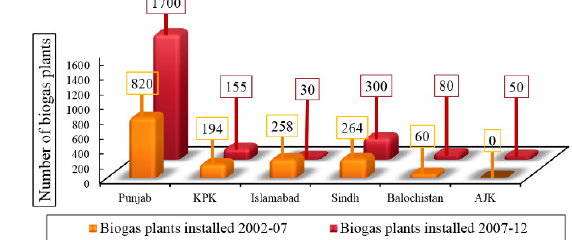
Fig. 7: Biogas plants installed by Pcret from 2002- 12 in different